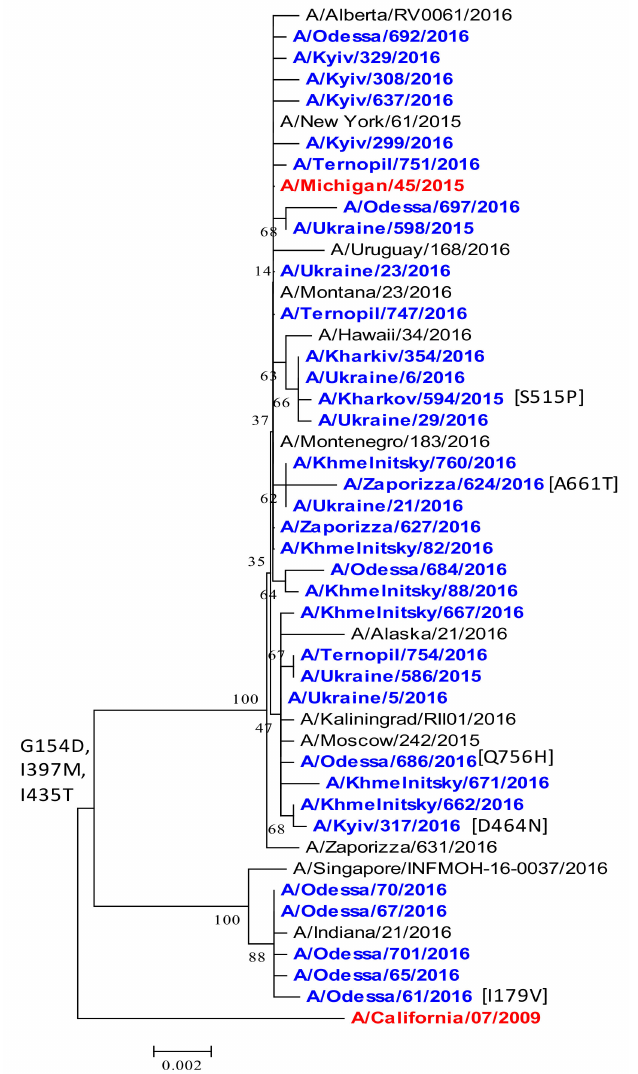
Figure 12. Phylogenetic comparison of A(H1N1)pdm09 influenza virus PB1 from the 2015/16 season. PB1 nucleotide sequences were analyzed by NJ method, Kimura 2-parameter model, with 1000 bootstrap replications. The Ukrainian 2015/16 isolates (blue), reference strains (black), and the vaccine strain